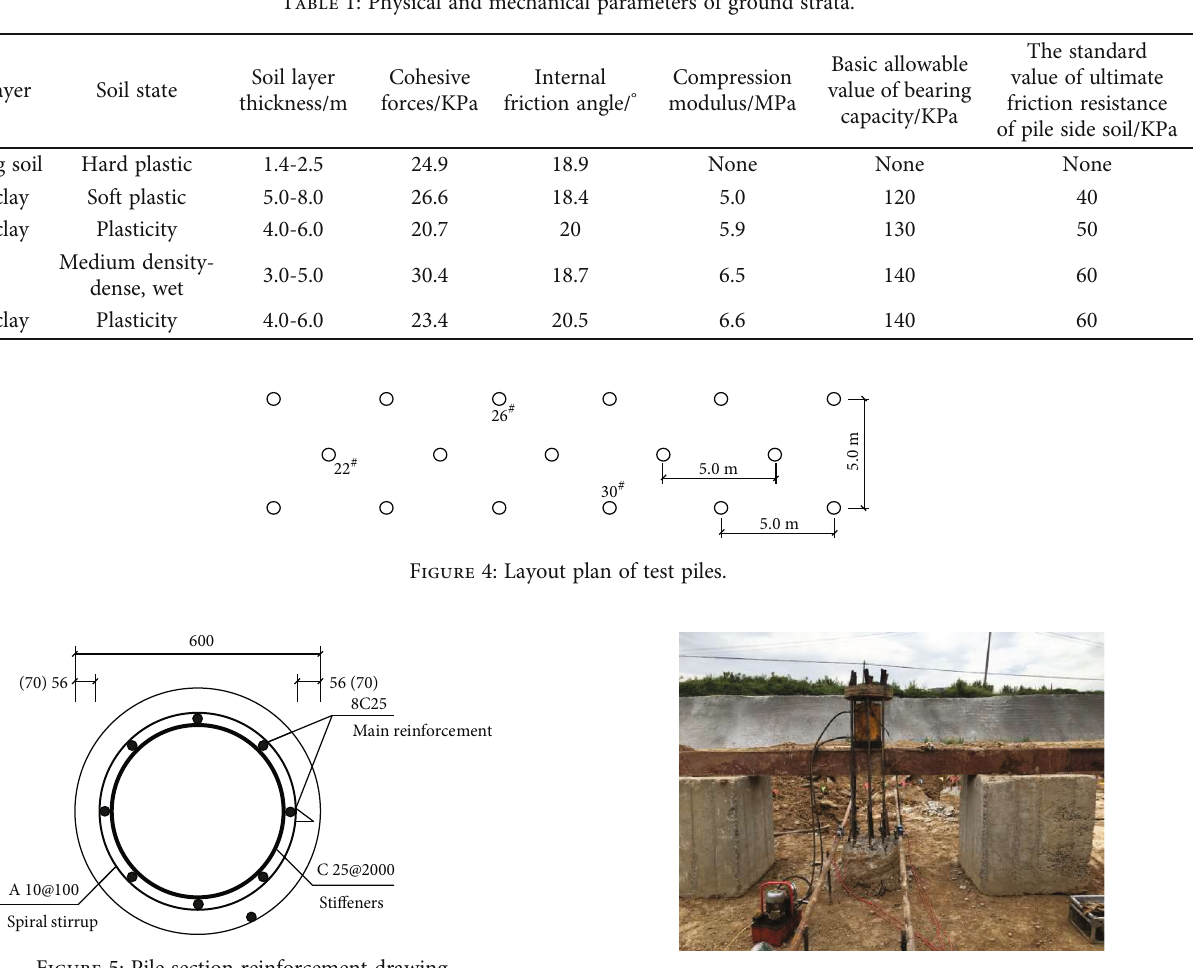
Figure 6: Field vertical pulling